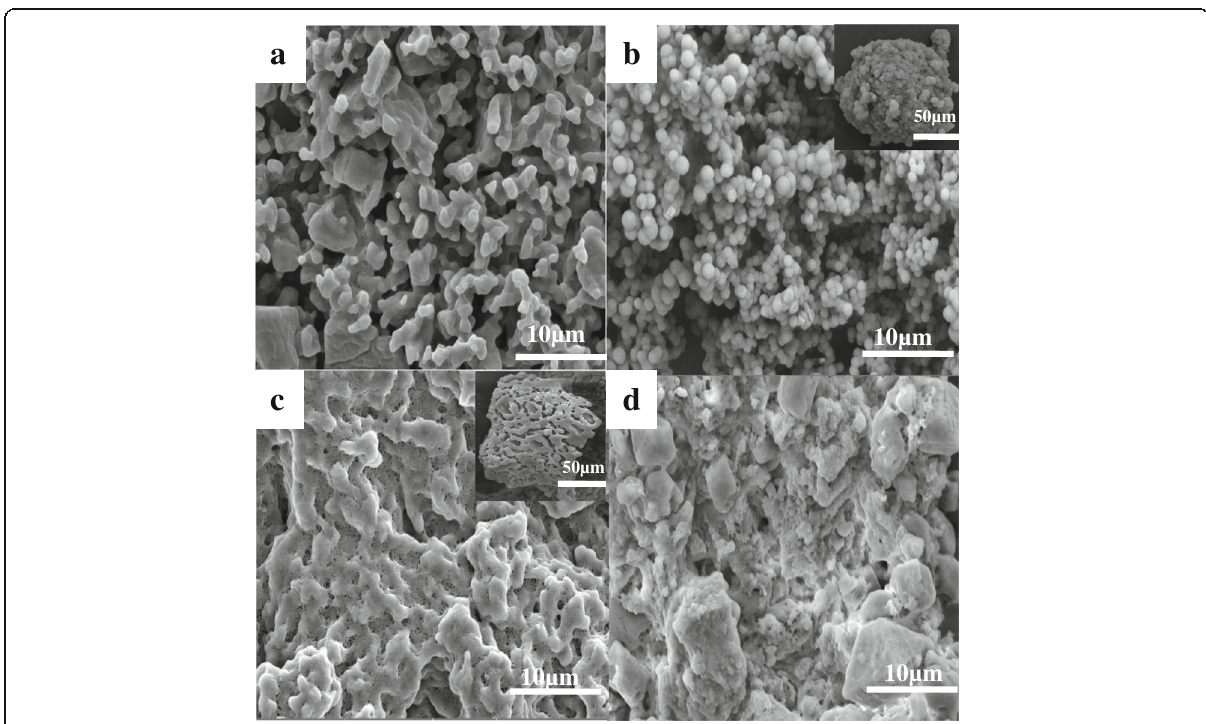
Fig. 3 SEM images of the uncoated HMX ( a ), HMX/MUF-1 ( b ), HMX/MUF-2 ( c ), and HMX/MUF-3 ( d ); corresponding images with low magnification are